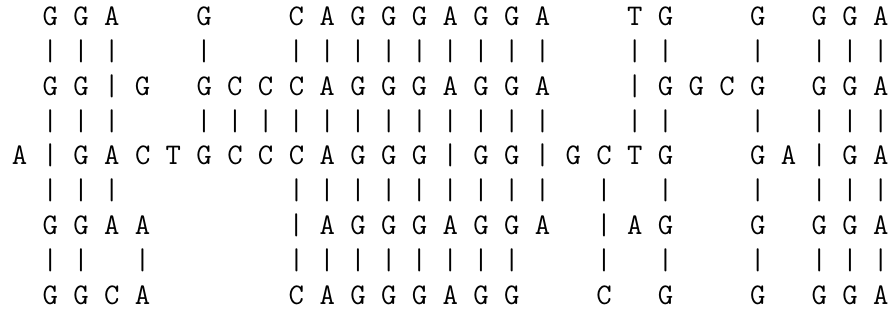
Figure A2. A ‘good’ multiple sequence alignment amongst five DNA sequences.